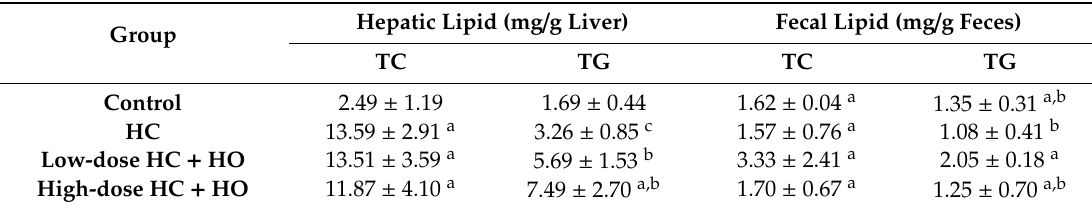
Table 7. Hepatic and fecal lipid of each